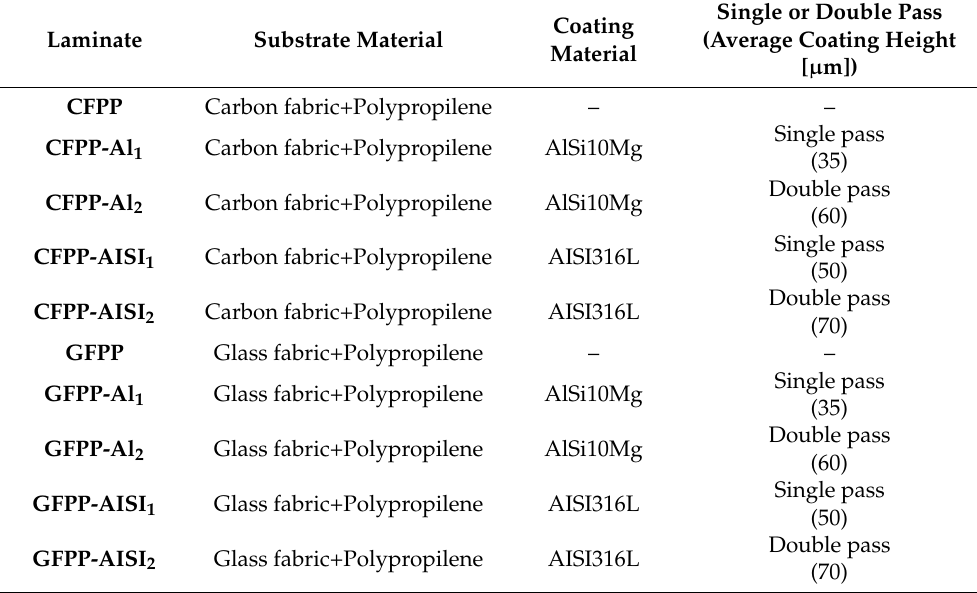
Table 2. Laminate characteristics examined in this experimental